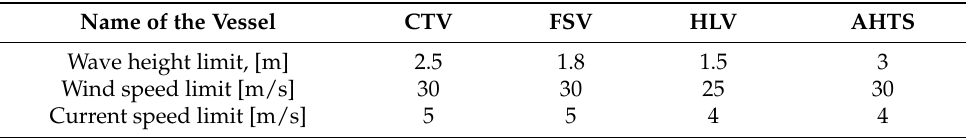
Figure 3. The cumulative distributions ( left ) and probability densities ( right ) of significant wave height in March from five candidate months identified by the component of extreme condition en- capsulations.